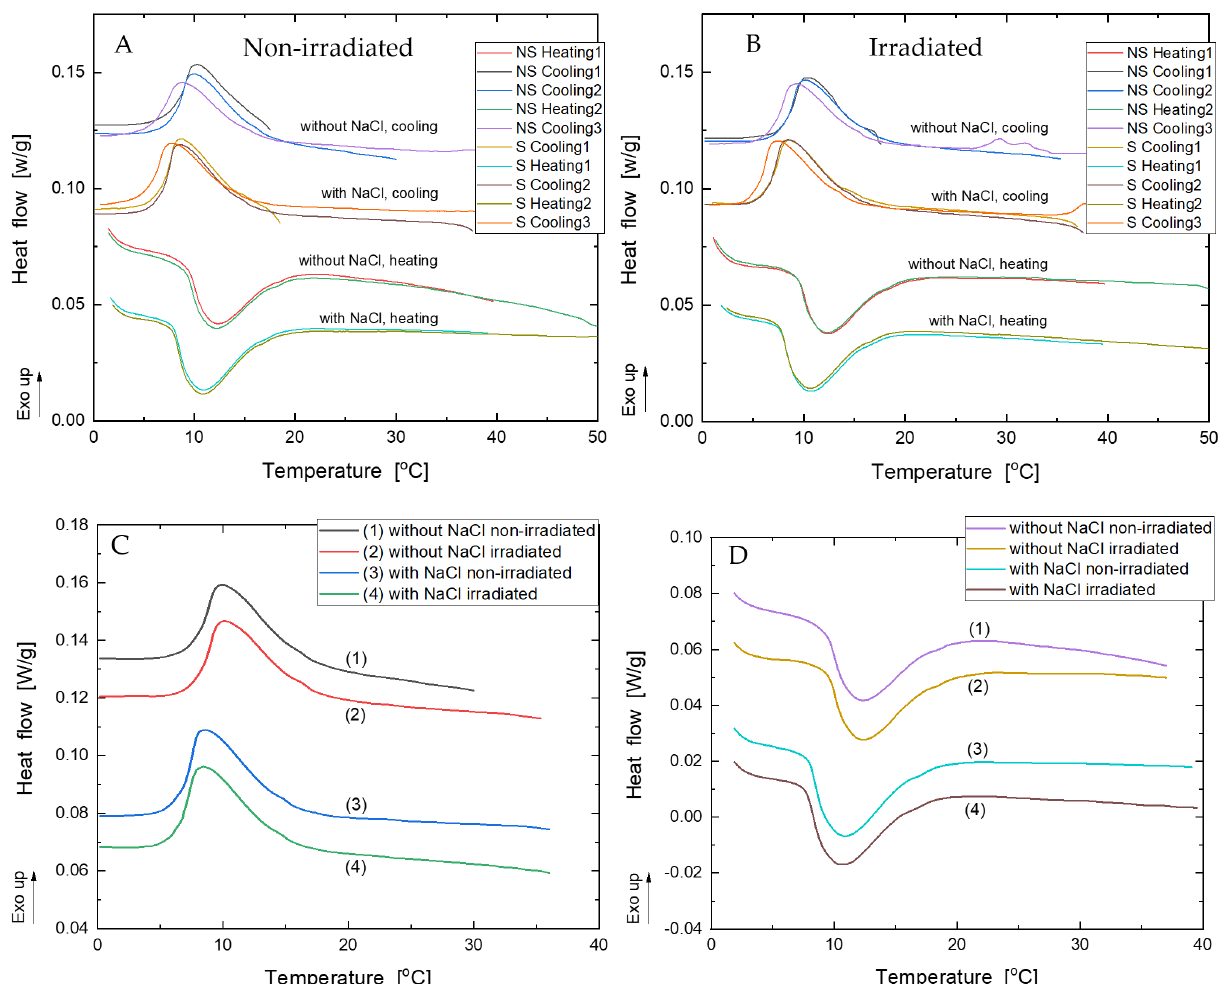
Figure 1. Photographs of non-irradiated Fricke-XO-Pluronic F-127 without ( A , C , E ) and with 0.2 M NaCl ( B , D , F ) during Test 1 observations. The temperatures of the gels are indicated in the photo- graphs. The colour change of the dosimeter occurred after 5 days of experiment. The initial colour of the dosimeter is light yellow-brown as observed in ( B ). The yellow dashed lines are to indicate the surface of the dosimeter at different temperatures.